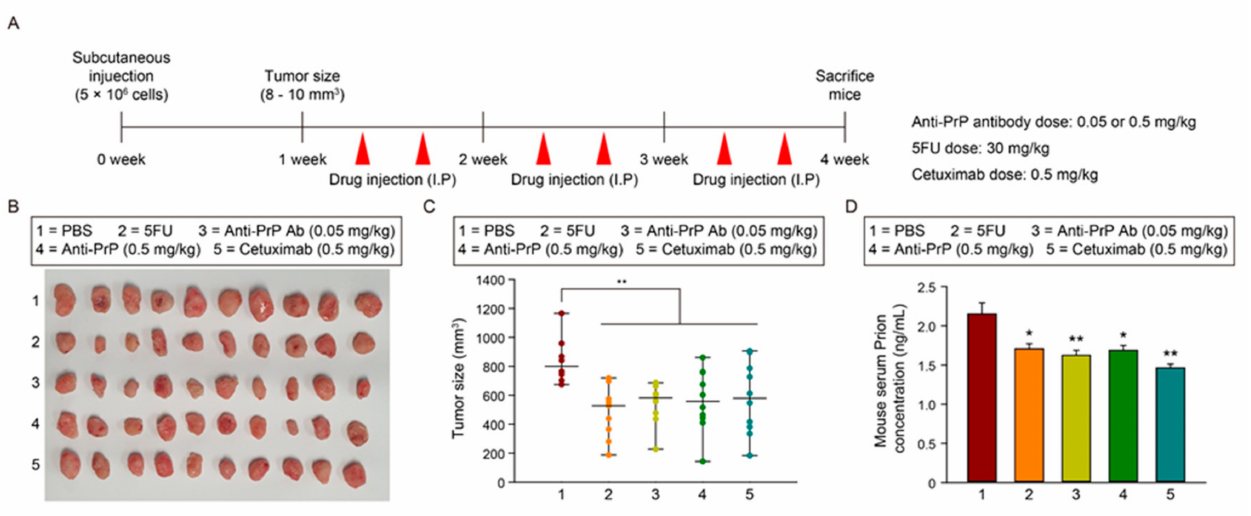
Figure 6. The effect of anti-PrP antibody in a CRC xenograft model. ( A ) Schematic illustration of SNU-C5/WT cells in vivo subcutaneously transplantation and injection with PBS, 5FU, anti-PrP antibodies (0.05 or 0.5 mg/kg), and cetuximab (0.5 mg/kg). ( B ) Photographs of tumor growth in a murine xenograft mouse model. ( C ) Quantification of tumor size in each group ( n = 10). (D) ELISA analysis of PrP C expression in sera isolated from a murine xenograft model ( n = 10). Data are presented as the mean ± SEM. * p < 0.05, ** p < 0.01